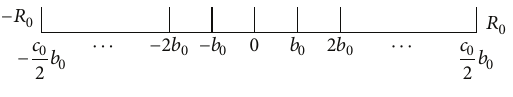
Figure 3: Variation ranges and